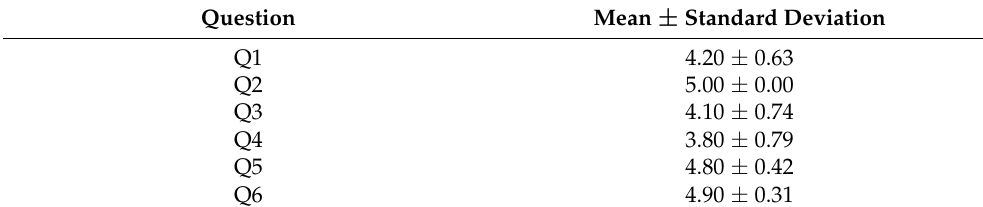
Table 5. Mean and standard deviation of the subjective questionnaire given to the 10 volunteers.